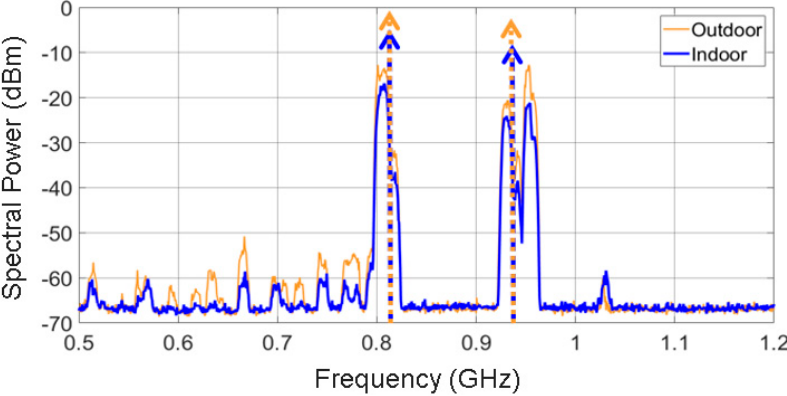
Figure 10. Zoom on the 800/900 MHz frequency bands over the spectrum acquired by the Archimedean spiral antenna (resolution bandwidth: 1 MHz).